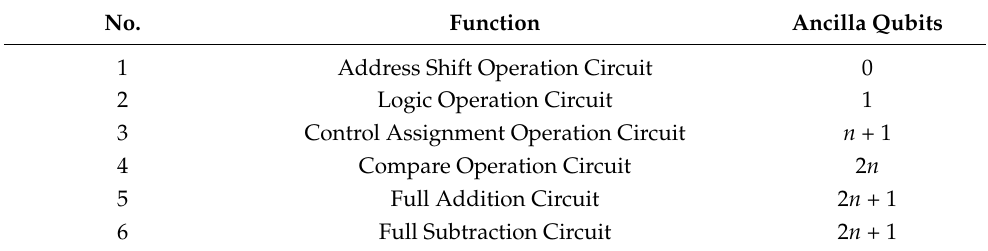
Table 1. Number of ancilla qubits used by the basic quantum functional circuits.